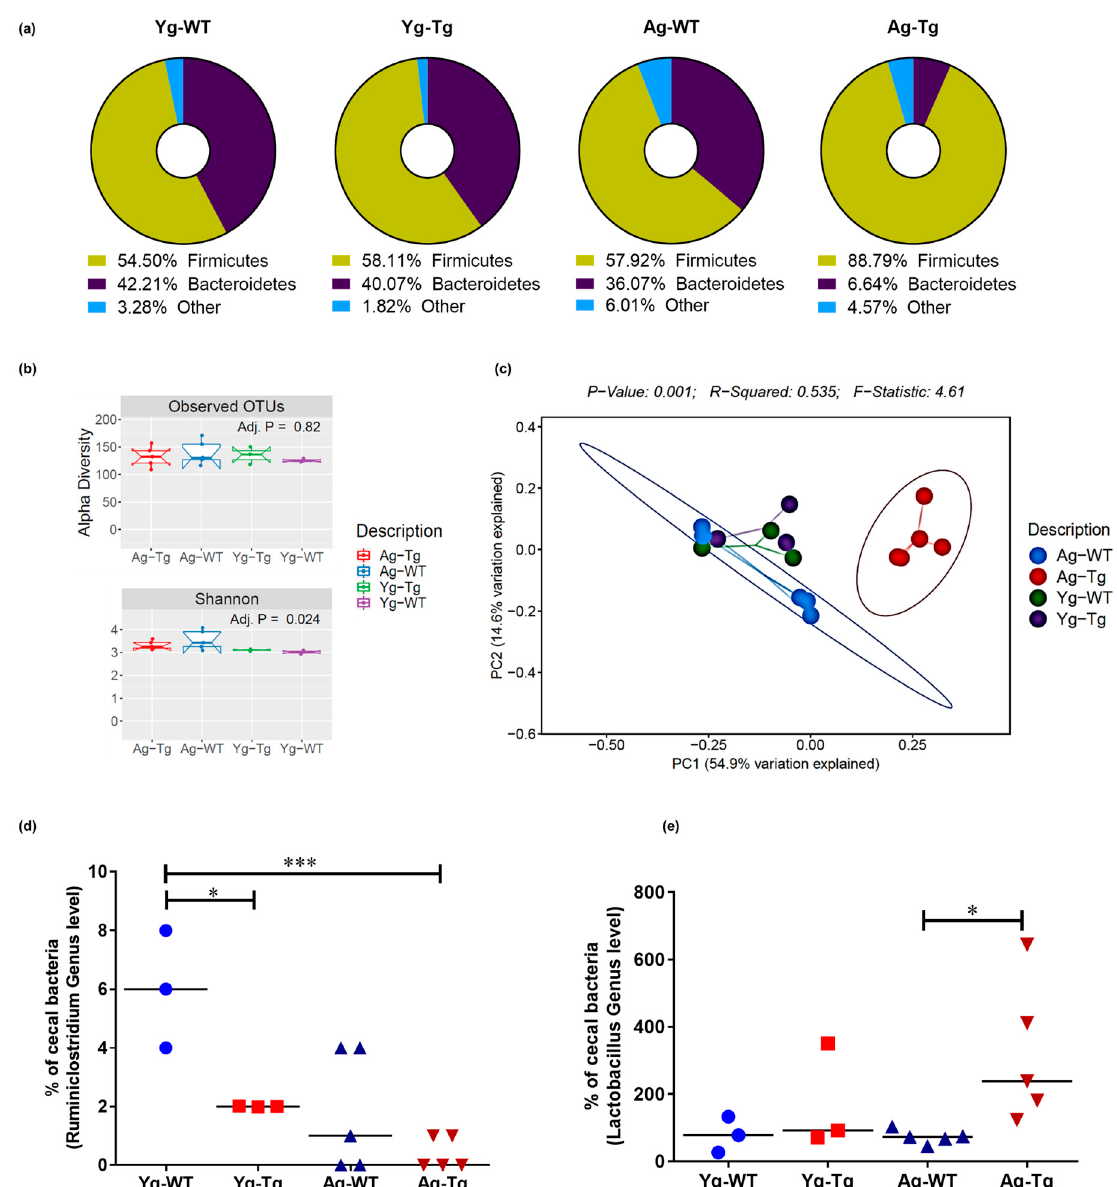
Figure 3. Compositional di ff erences in gut microbiota by 16S rRNA sequencing of intestinal luminal content. ( a ) Average enrichment of top bacterial phyla of Firmicutes and Bacteroidetes in Tg2576 vs. WT littermate controls by qPCR. ( b ) Visualization of beta-diversity, or between-sample diversity, with weighted UniFrac distances by principal coordinate analysis (PCoA) shows a clustering e ff ect by strain between Tg2576 and WT littermate controls at 15 months, which is not observed at 6 months. ( c ) Number of observed Operational Taxonomic Units (OTUs) and the alpha-diversity, or within-sample diversity (Shannon diversity index) when comparing Tg2576 and WT littermate groups. ( d ) Di ff erences at the genus level show a significantly reduced abundance of Ruminiclostridium in the cecal content of Tg2576 mice starting at 6 months and persisting at 15 months compared to age-matched WT littermate controls. ( e ) Di ff erences at the genus level show a significant increase in Lactobacillus abundance in Tg2576 mice at 15 months, which was not present at 6 months, when compared to age-matched WT controls. n = 3,5 per group. Data are expressed as mean ± SEM, as well as individual values, and are obtained from > 2 independent experiments at various times. * p < 0.05, *** p < 0.001. P values were calculated using Two-Way ANOVA analysis with Sidak’s multiple comparisons correction ( d , e ).